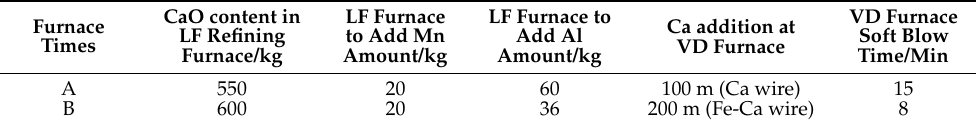
Figure 1. The production process of H08A welding rod steel. Table 2. The operation parameters of calcium treatment in industrial production.